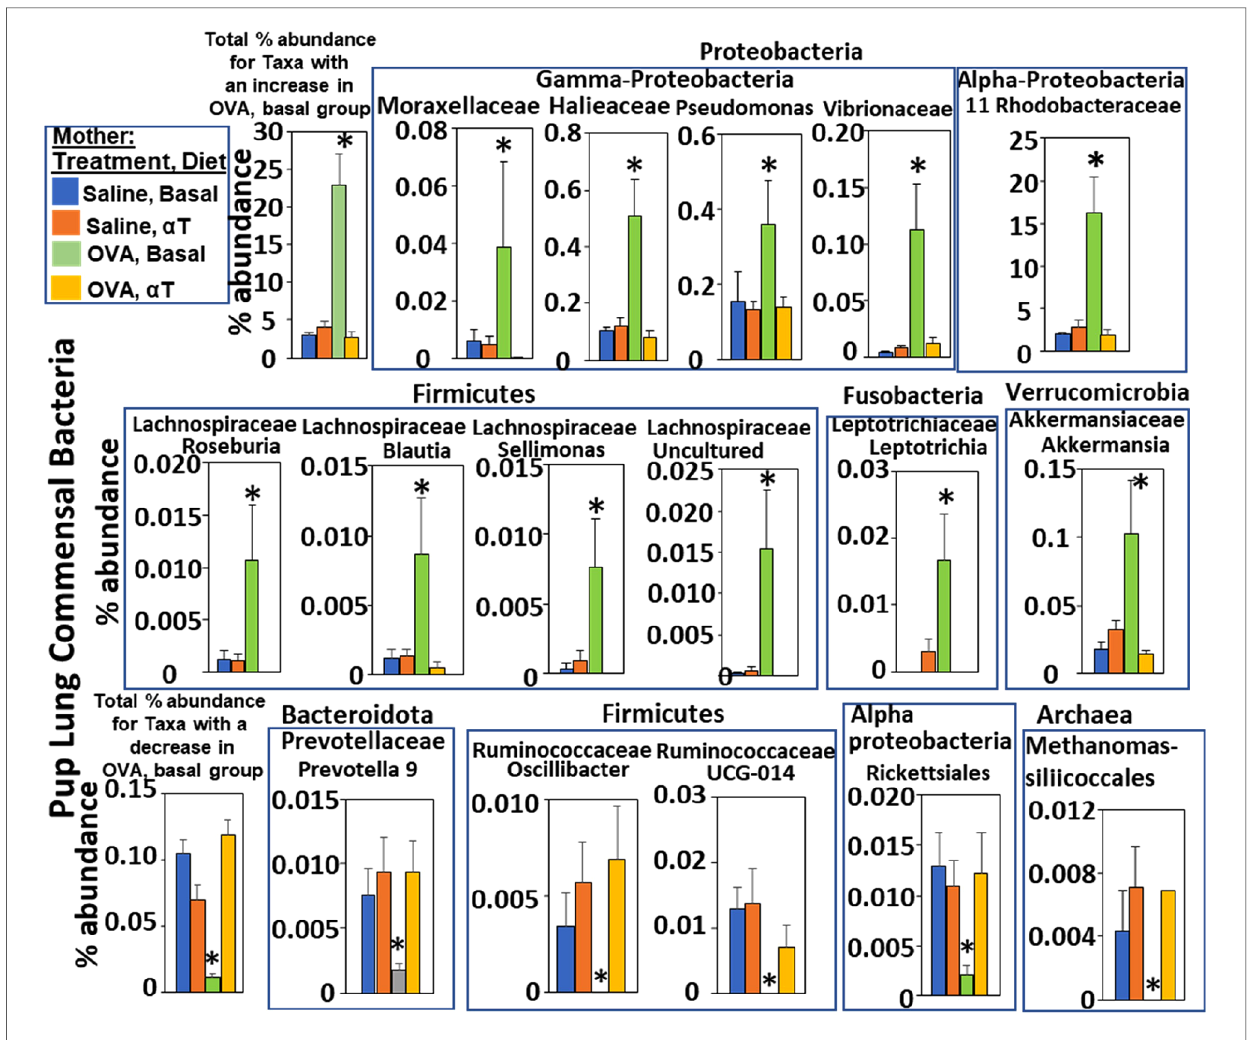
FIGURE 3 Pups of allergic mothers have altered bacteria microbiome. Mouse treatments were as in ( Figure 1A ). Pup BAL microbiota were separated and analyzed by 16S rRNA gene sequencing at PND16. Shown are the % abundance for pup BAL bacteria with a signi fi cant difference in the OVA/Basal group compared to the other groups. * p